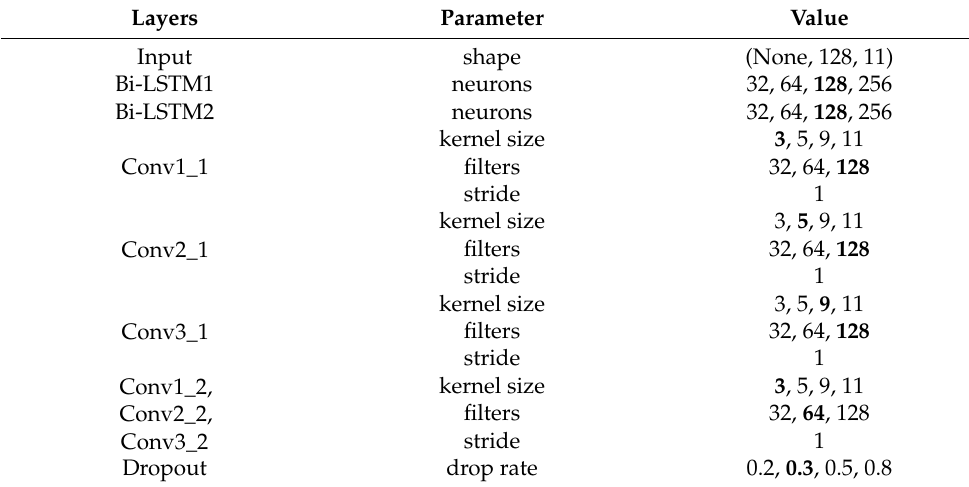
Table 1. Landmark identification neural network